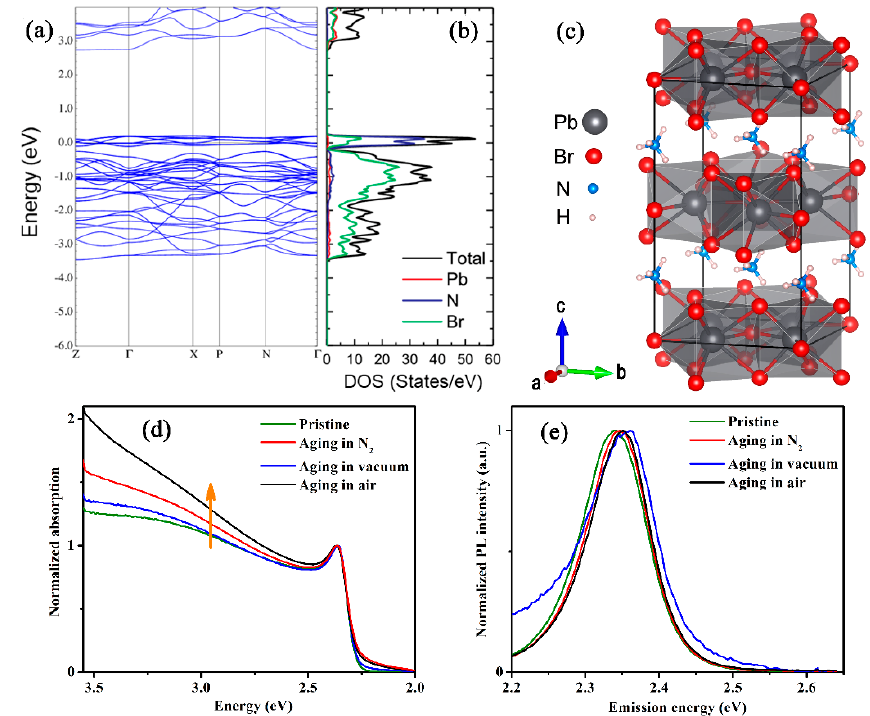
Figure 4. ( a ) Electronic band structure and ( b ) the density of states (DOS) of NH 4 Pb 2 Br 5 calculated using the full-potential linearized augmented plane wave (FP-LAPW) method implemented in the WIEN2K code. ( c ) Crystal structure of tetragonal NH 4 Pb 2 Br 5 . ( d ) Normalized absorption spectra and ( e ) normalized PL spectra of the pristine MBNCs-PVDF and the samples after aging in three different atmospheres. The temperature and 368 nm UV light irradiation density during aging are 323 K and 5.6 mW/cm 2 .